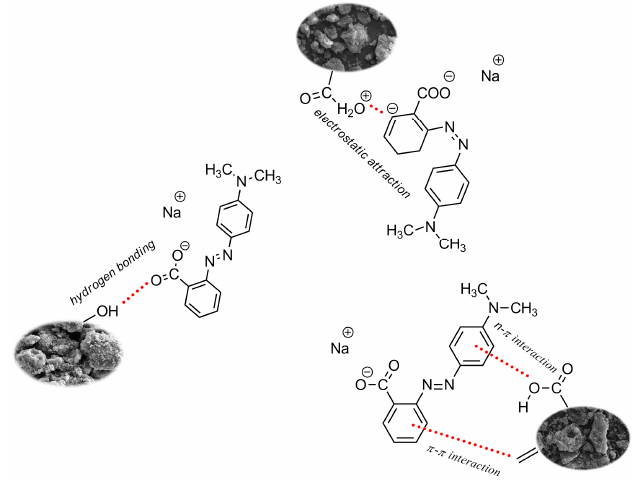
Figure 8. Organic dye adsorption on biocarbons.